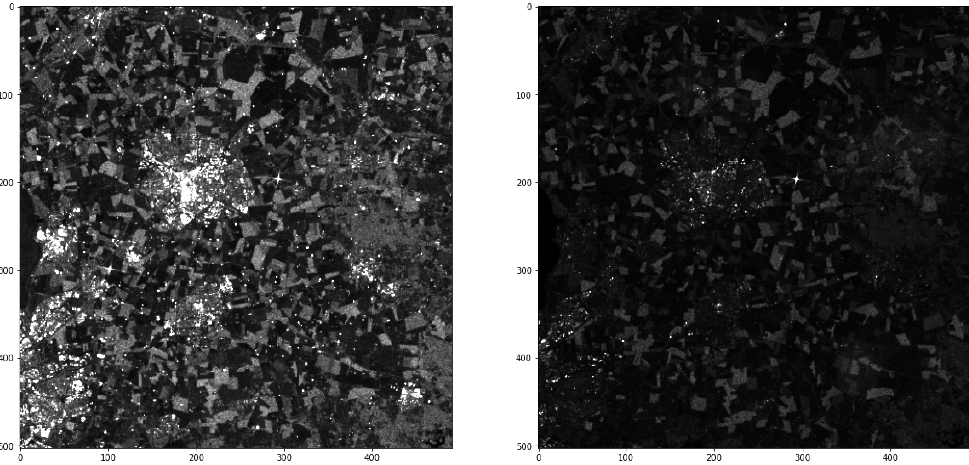
Figure 1. Typical level-1 SAR backscatter, VH ( left ), and VV polarization ( right ), with orthorectifica- tion and radiometric calibration.